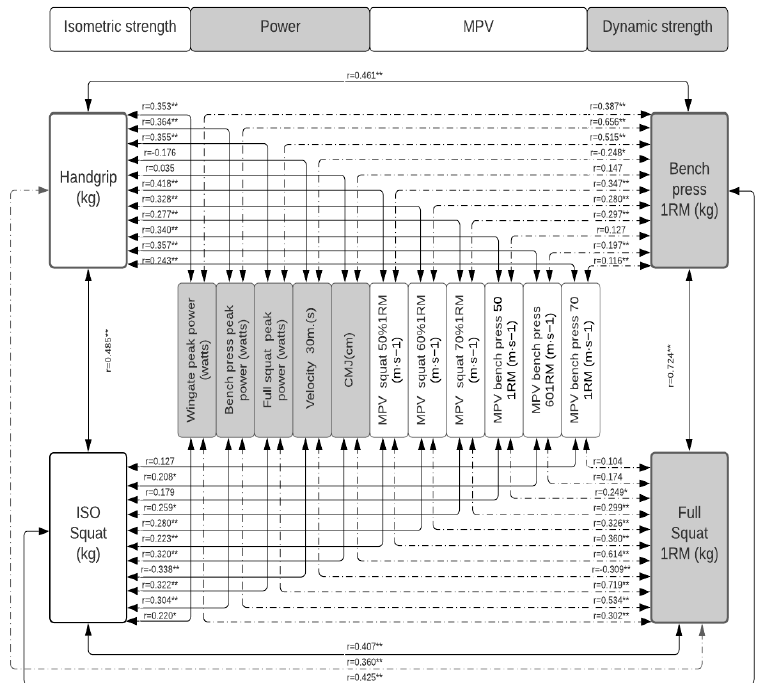
Figure 2. Correlation between the measures of absolute maximum strength and power in the group of women. Significance: * p < 0.05; ** p < 0.001.